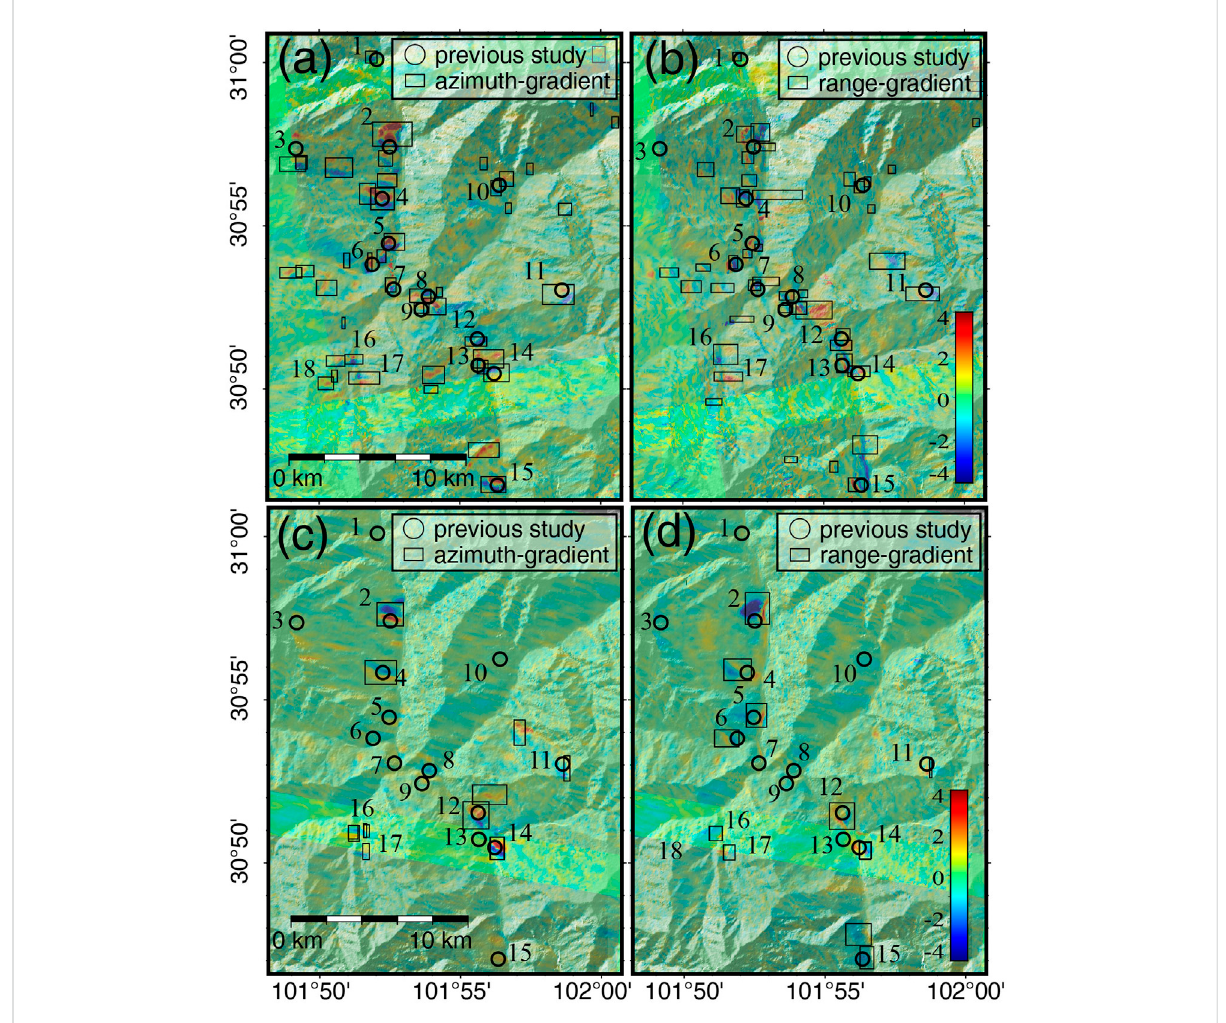
FIGURE 10 Detectedslow-movinglandslides(boxes)inDanbaCountyusingphase-gradientstackingandAttention-YOLOv3 networkin (A,C) azimuthand (B,D) range directions obtained from AT26 (A,B) and DT135 (C,D) images. Circles labeled 1 to 15 mark locations of landslides identi fi ed in Dong et al.